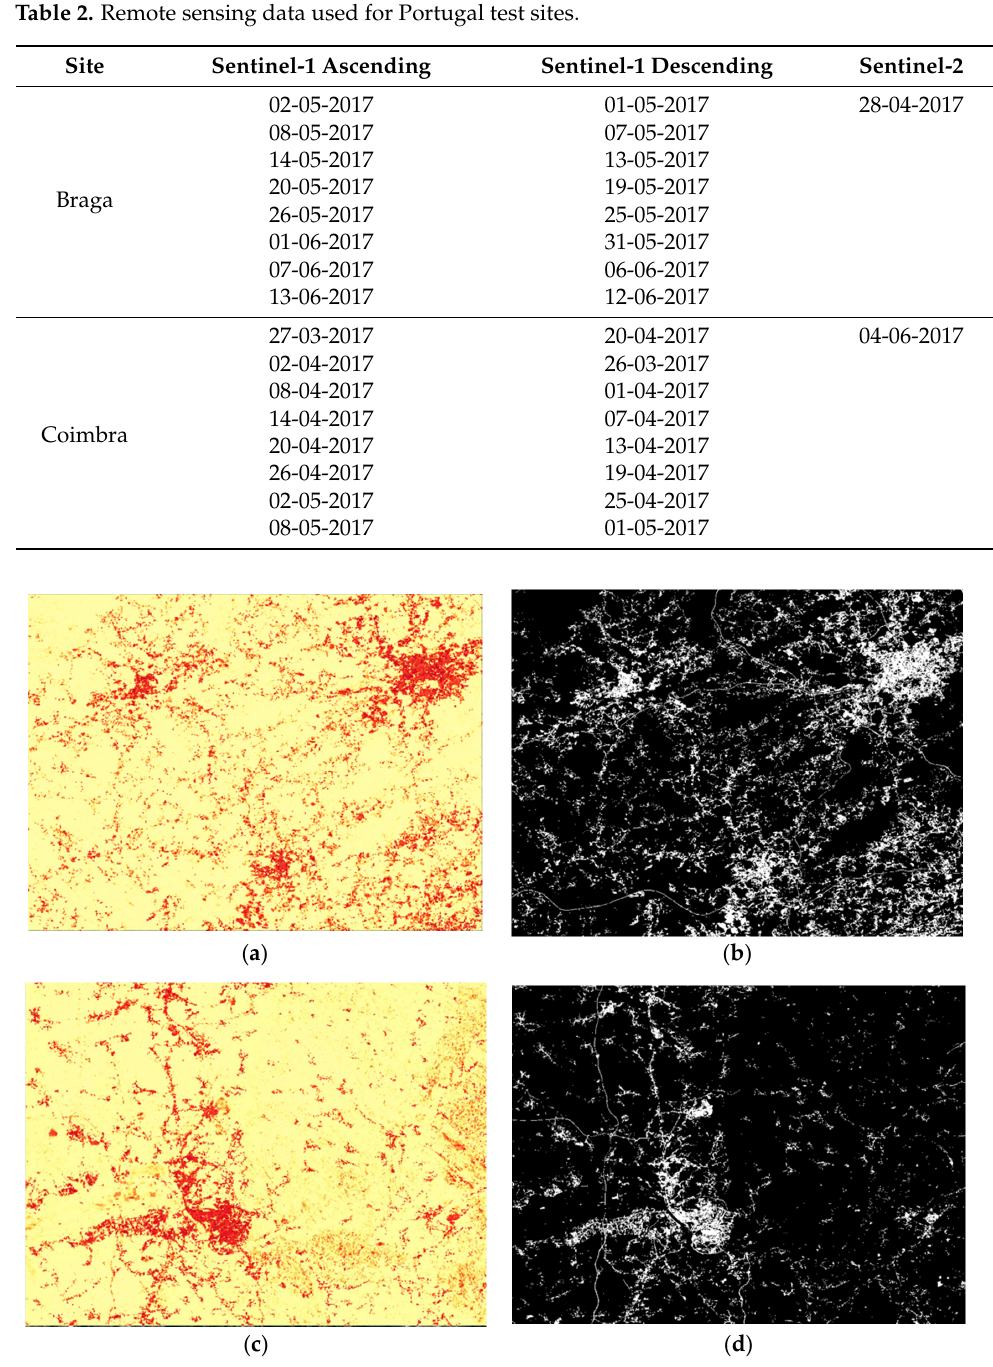
Figure 12. FCM classification results for Braga ( a ) and Coimbra ( c ). Color scale quantifies the membership level of each segment to the urban class, where red: urban pixels, yellow: non-urban pixels. ( b , d ): S2GLC reference binary map where white: urban pixels, black: non-urban pixels. GUF is a binary settlement map derived from high-resolution SAR missions